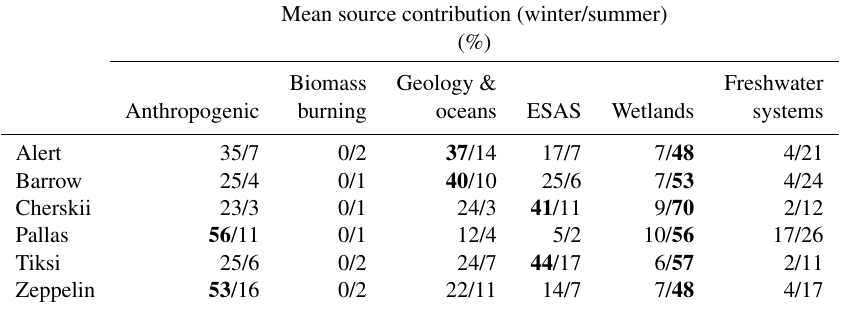
Table 3. Mean source contributions (in %) to atmospheric CH 4 (excluding CH 4 resulting from the boundary conditions) simulated by CHIMERE at the six observation sites, over winter (November–May, left value) and summer (June–October, right value) 2012. In bold font the major source at each site is highlighted for both seasons.